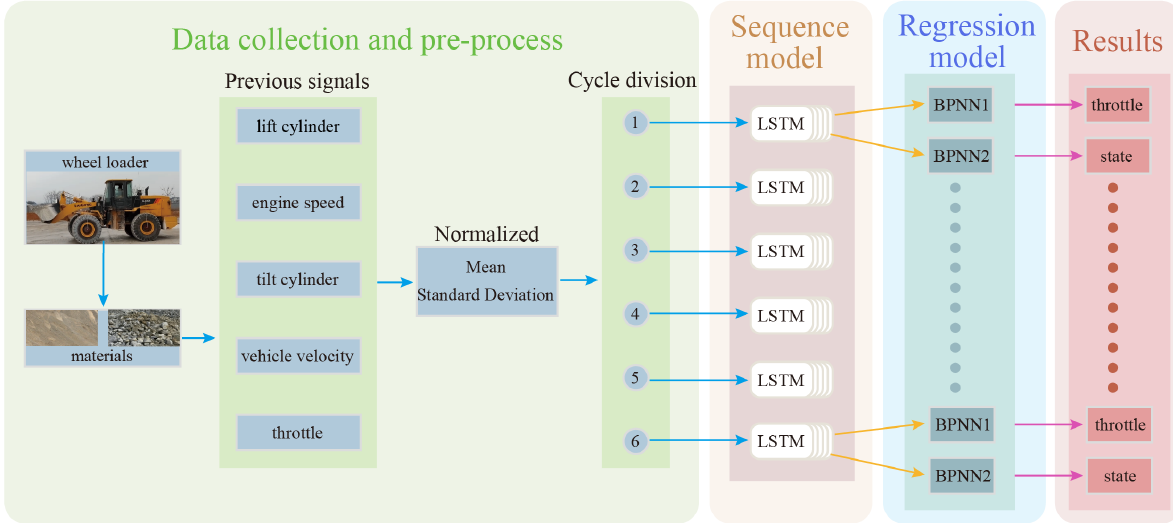
Figure 3. The model presented in this paper.